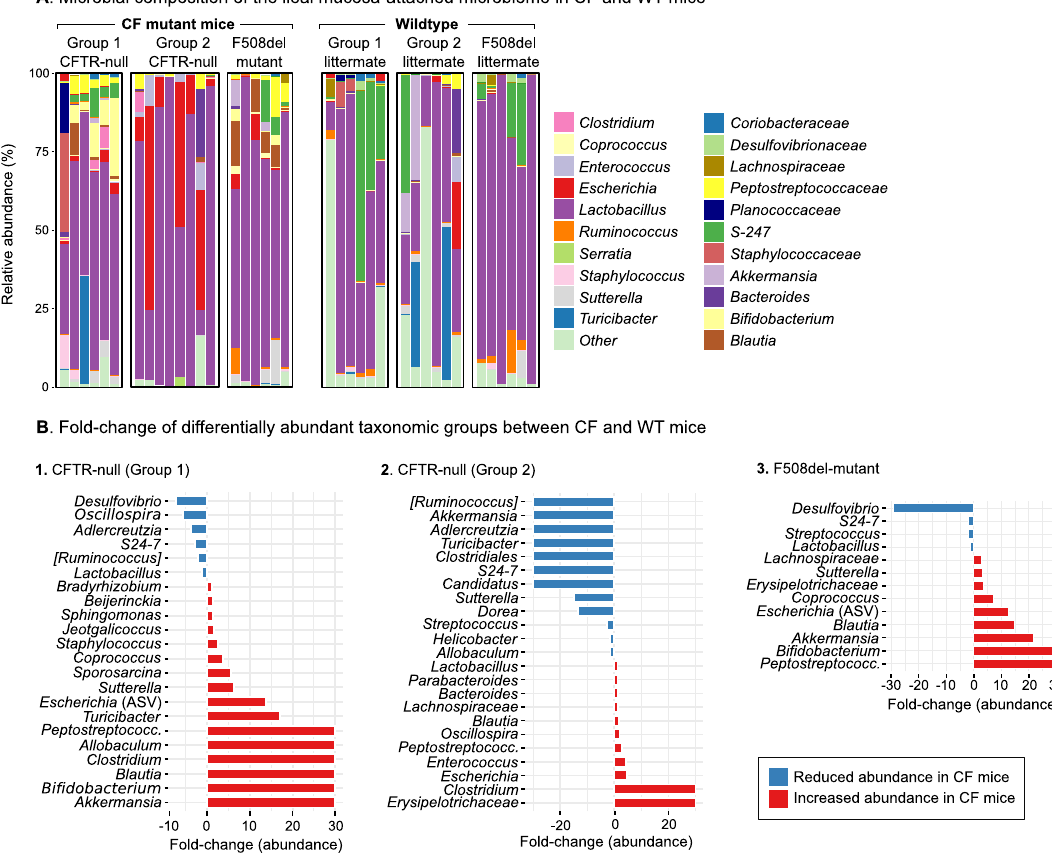
Figure 2. ( A ) Stacked bar plot showing the genus-level microbial composition of the ileal mucosa-attached microbiome in CFTR-null, F508del-mutant and WT littermate mice. Colours represent individual genera. ( B ) Horizontal bar chart showing the fold-change in relative abundance of important taxonomic groups in (1) CFTR-null mice group 1, (2) CFTR-null mice group 2 and (3) F508del-mutant mice compared to their WT littermate controls. Red bars indicate increased abundance in CF compared to WT mice, whilst blue bars indicate reduced abundance in CF compared to WT mice. For the complete list of differentially abundant taxa, see the Supplementary Tables. All taxa exhibiting a fold change above 30 are capped at that value for visualisation